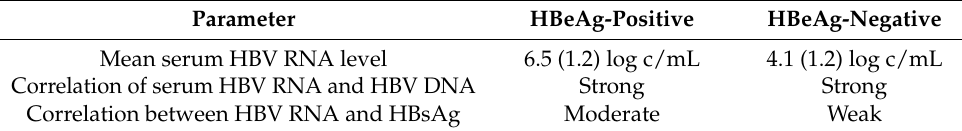
Table 4. Comparison of HBV RNA parameters in HBeAg-positive and HBeAg-negative